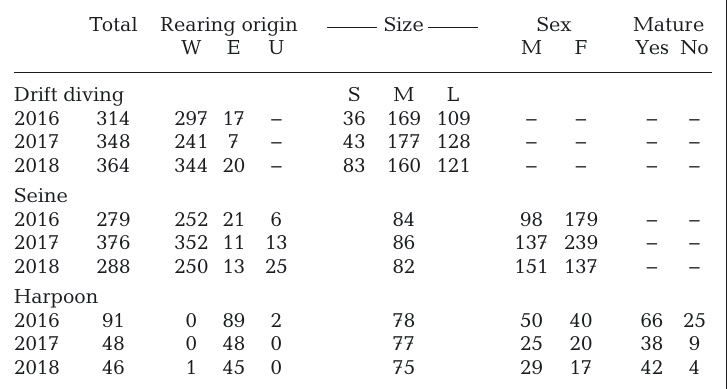
Table 2. Net captures, drift dive observations, and harpoon removals of At- lantic salmon. Rearing origin was determined from scale readings, and indi- viduals were classified as wild (W), escaped (E), or unknown (U). Scales were classified as unknown if they were missing, damaged, or new (i.e. lacking an entire growth cycle). Size was categorized by weight for drift diving (small [S]: <3 kg; medium [M]: 3 to 7 kg; large [L]: >7 kg) and by mean length